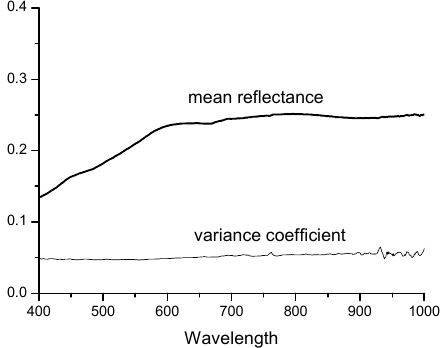
Figure 3. Ground reflectance and variance coefficient of the Dunhuang test site.